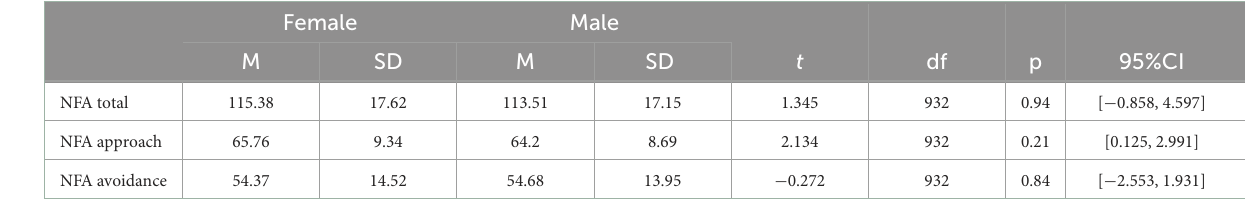
TABLE 3 Distribution of NFA Questionnaire scores.